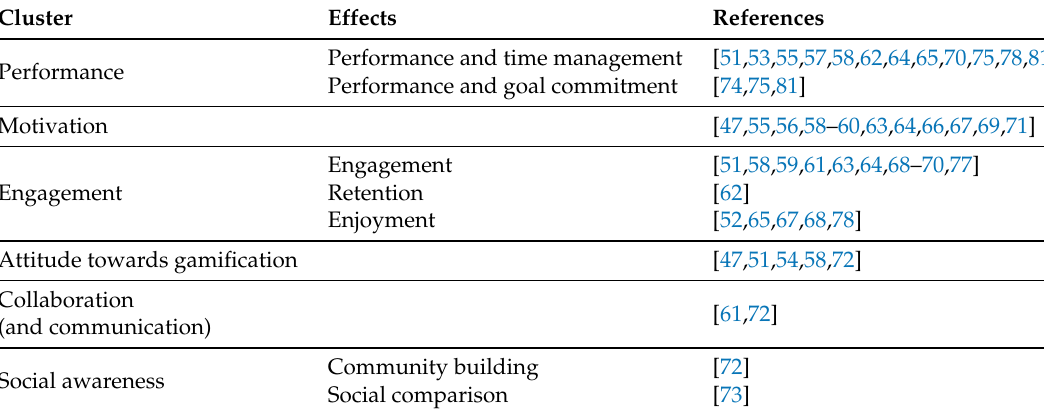
Table A3. The users’ behaviour and characteristics affected by